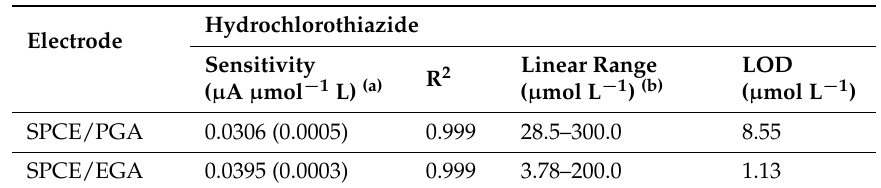
Table 1. Calibration data for the determination of HCTZ by DPV on SPCE/PGA and SPCE/ EGA in the presence of 0.01 mol L − 1 hydrochloric acid.